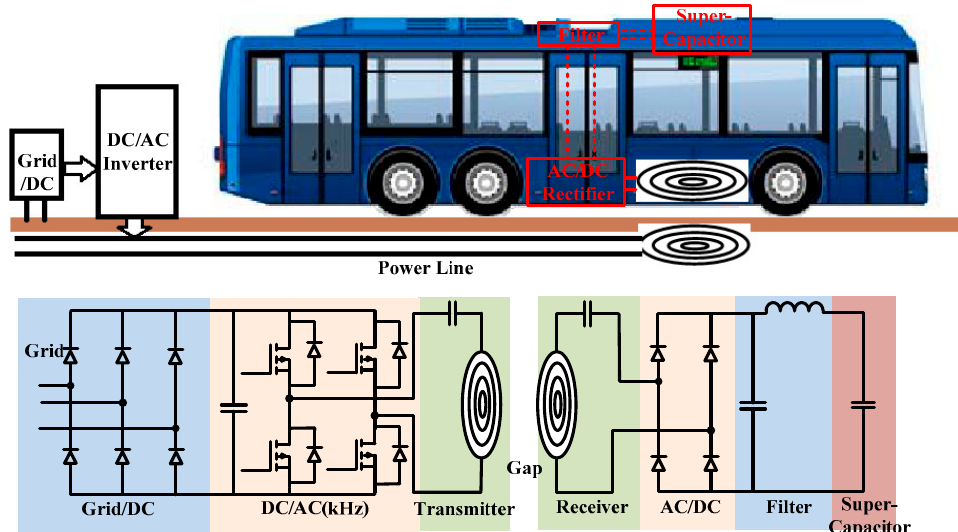
Figure 1. WPT system configuration in rail transit vehicle.